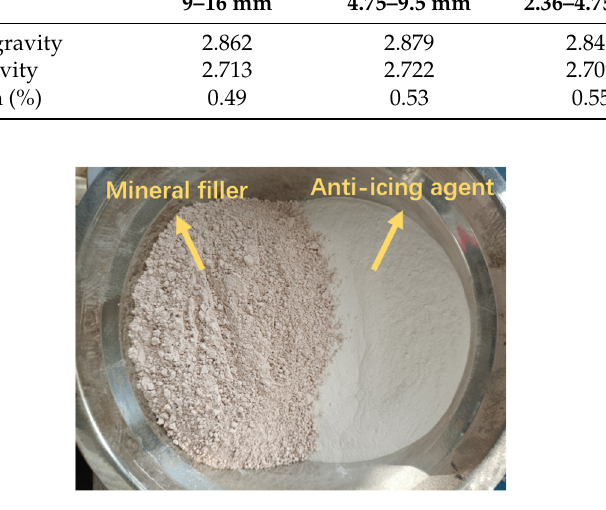
Figure 2. Mineral filler and ZGHIT deicing agent.